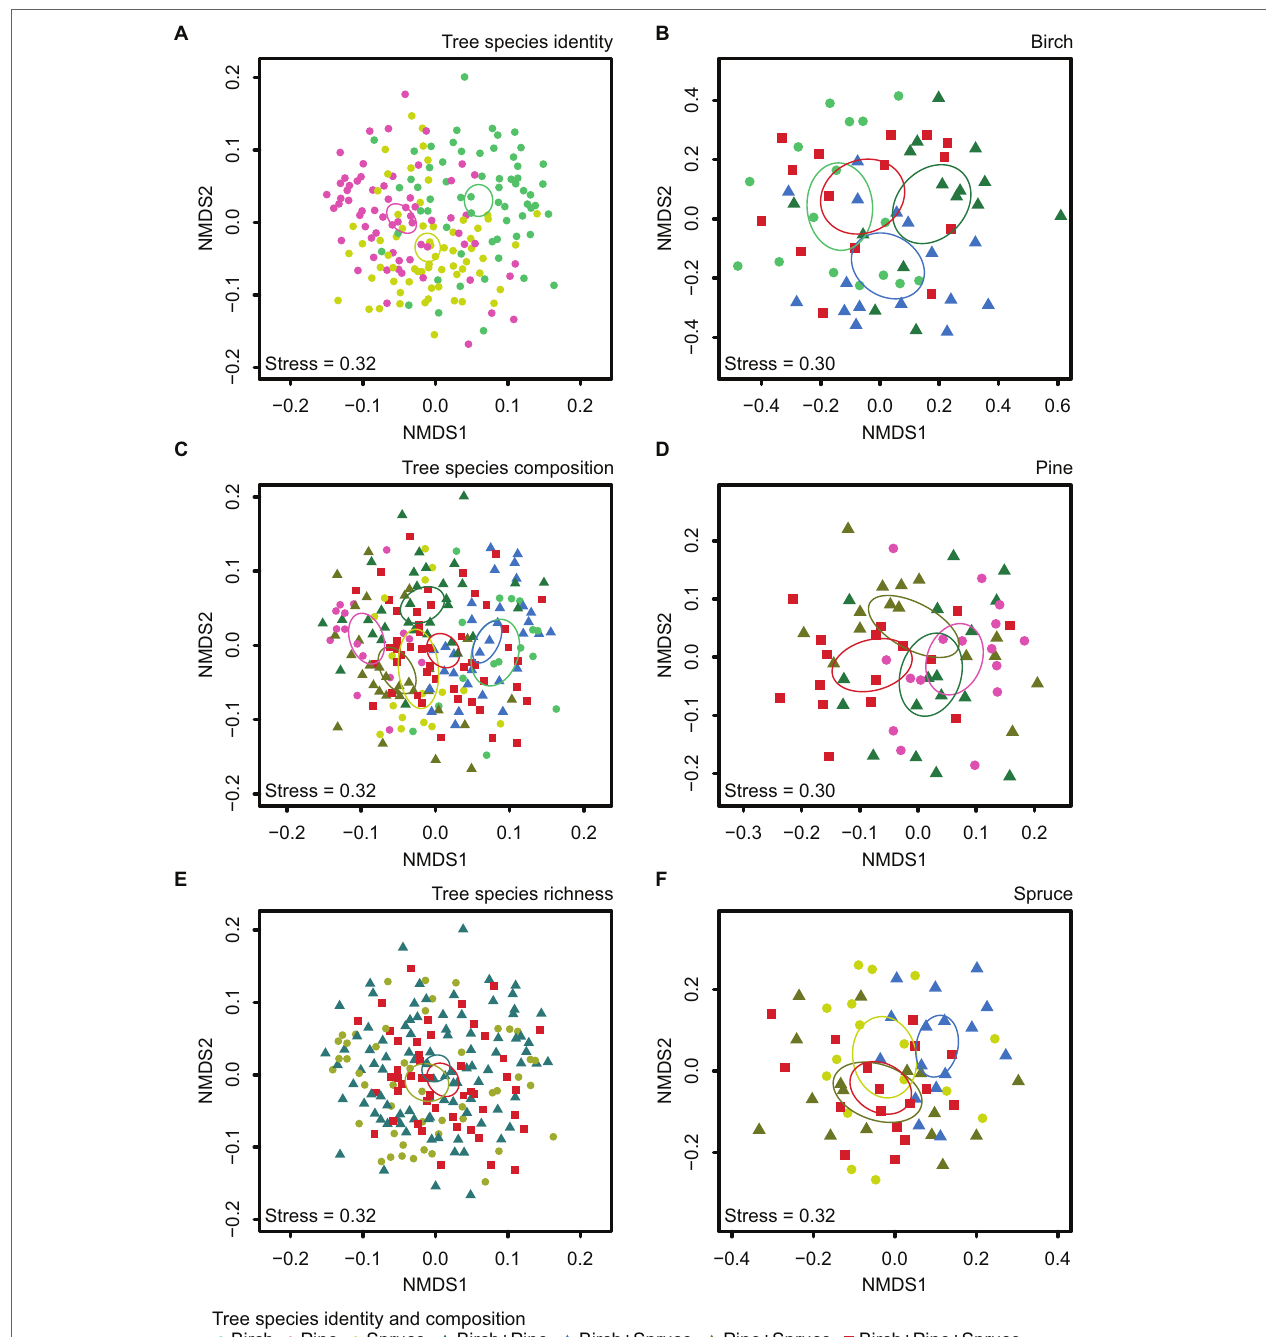
FIGURE 5 | NMDS plots of EcM fungal community composition for the three studied factors: (A) tree species identity, (C) tree species composition, and (E) tree species richness. Tree species composition effects were visualized separately for (B) B. pendula , (D) P. sylvestris and (F) P. abies . Ellipses denote 95% CIs for the different